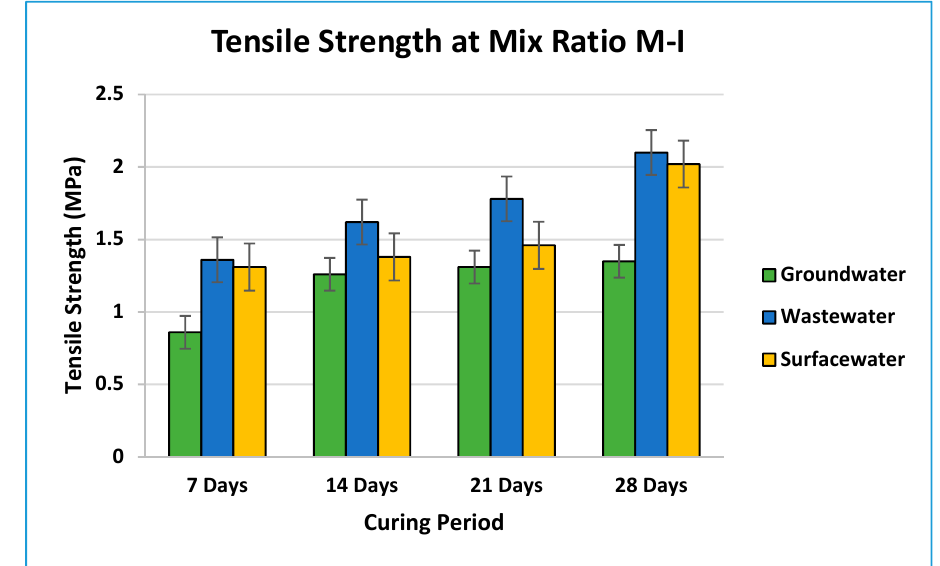
Figure 6. Split tensile strength of concrete for the ratio M-I (1:2:4).